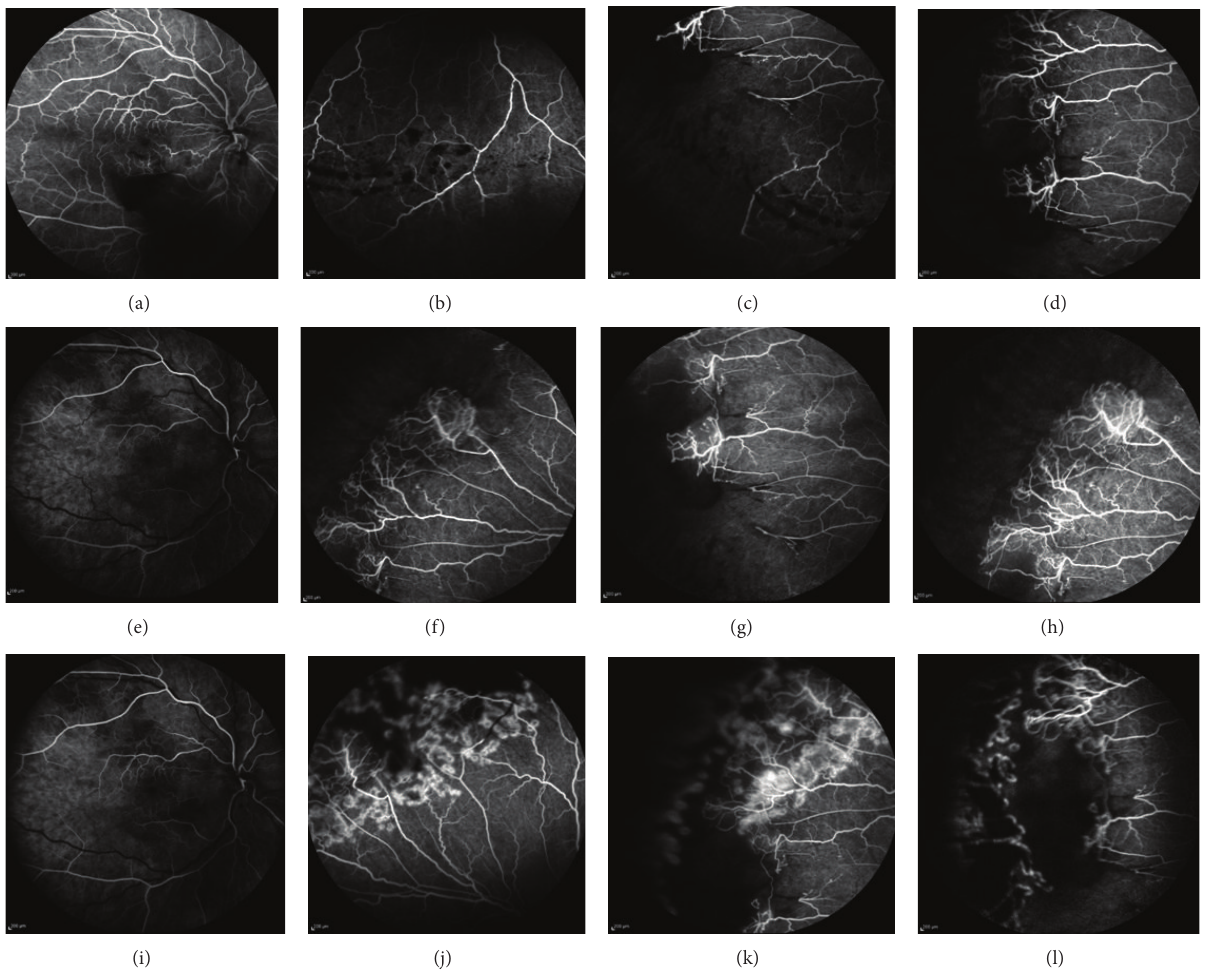
Figure 3: (a–d) Fluorescein angiography, showing improvement of vitreous hemorrhage and slight regression of neovascularization, but presence of ischemic areas, one week after intravitreal ranibizumab injection; (e–h) fluorescein angiography, showing total absorption of vitreous hemorrhage, regression of neovascularization and ischemia at the periphery one month after intravitreal ranibizumab injection; (i– l) fluorescein angiography, showing laser photocoagulation spots in the previous ischemic areas, no recurrence of vitreous hemorrhage, and regression of neovascularization compared to